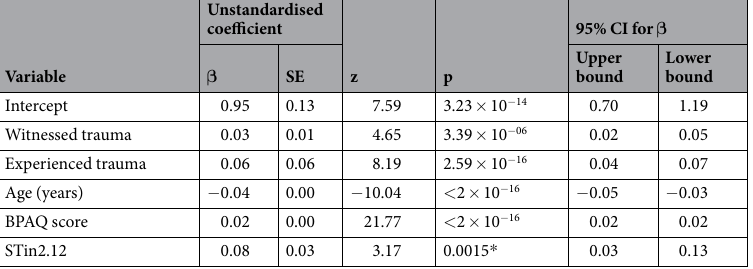
Table 2. Association between SLC6A4 STin2 variant and appetitive aggression (AAS score), using additive genetic models. Abbreviations: β , estimated Poisson regression coefficients for the model; SE, standard error of the individual regression coefficients; z, z-test statistic; CI, confidence interval; BPAQ, Buss-Perry Aggression Questionnaire; BPAQ, Buss-Perry Aggression Questionnaire; STin2.12, 12-repeat allele of the serotonin transporter intron 2 variant. Hosmer-Lemeshow goodness-of-fit: χ 2 = − 3.95, df = 8, p-value = 1. * Benjamini- Hochberg corrected p =